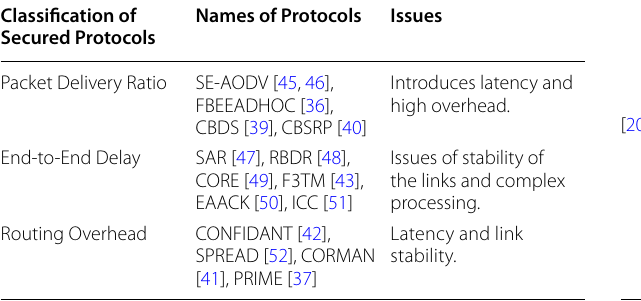
Table 3 Summarizing secure routing protocols on the basis of QOS categories and their